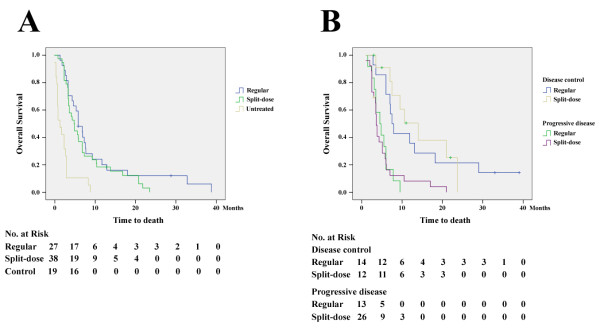
Survival analysis of patients with advanced HCC treated by FMP. (A) Overall survival in the two treated groups and the untreated group of patients. (B) Overall survival in the two groups of patients (regular and split-dose) achieving disease control and progressive diseases.